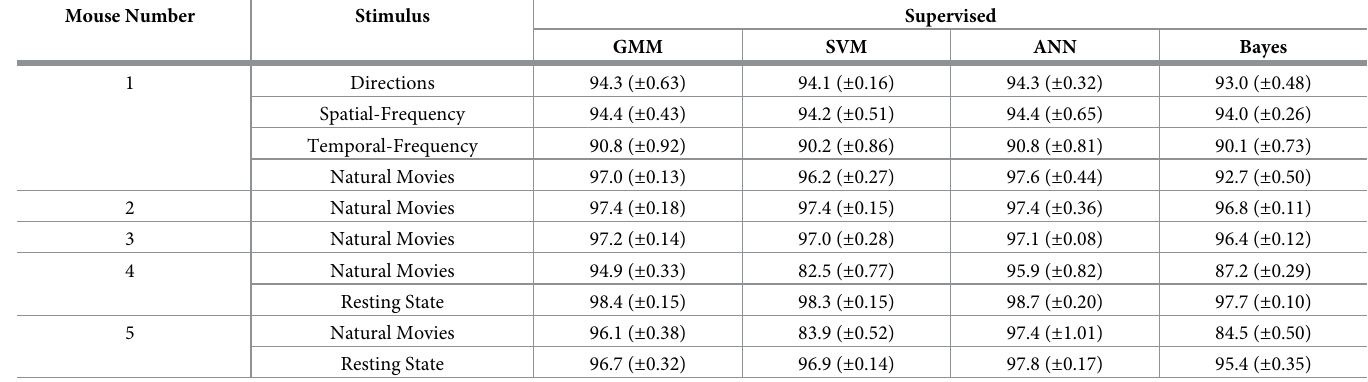
Table 3. Accuracy of supervised classification on wide-field data. The results are averaged across random initializations. The entries denote “ % accuracy (± standard deviation)